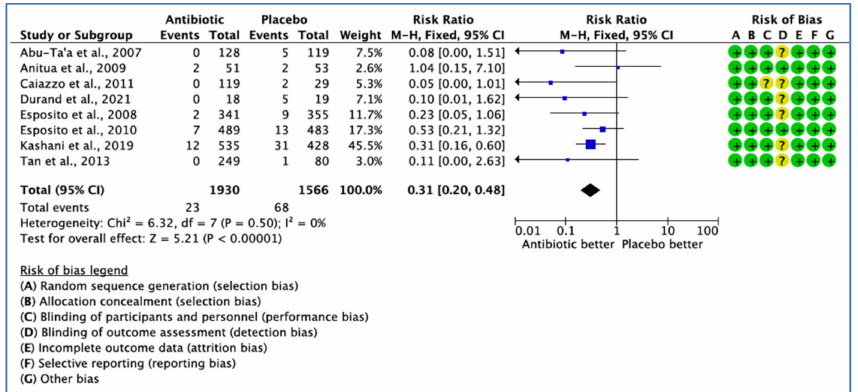
Figure 3. Forest plot of comparison between AB and placebo, which gives a summary estimate (centre of diamond) and its 95% confidence interval CI (width of diamond) for the number of failed implants by implant. Statistical method: Mantel-Haenszel with fixed-effect model [25–27,29,31,32,34,36].